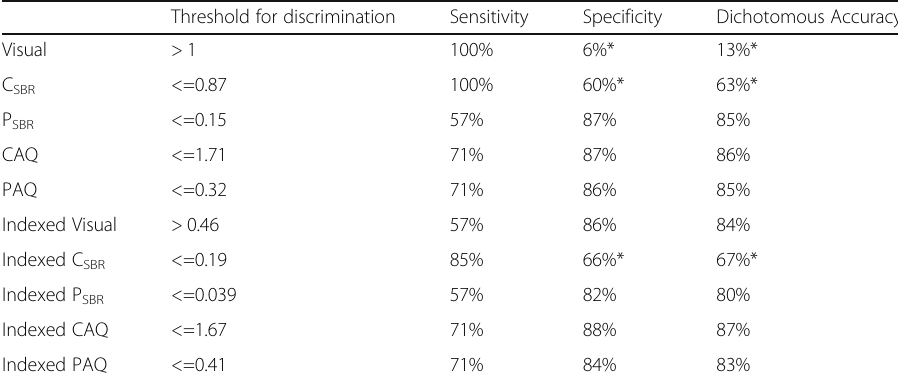
Table 4 ROC result for discriminating patients with DLB from those with PD Threshold for